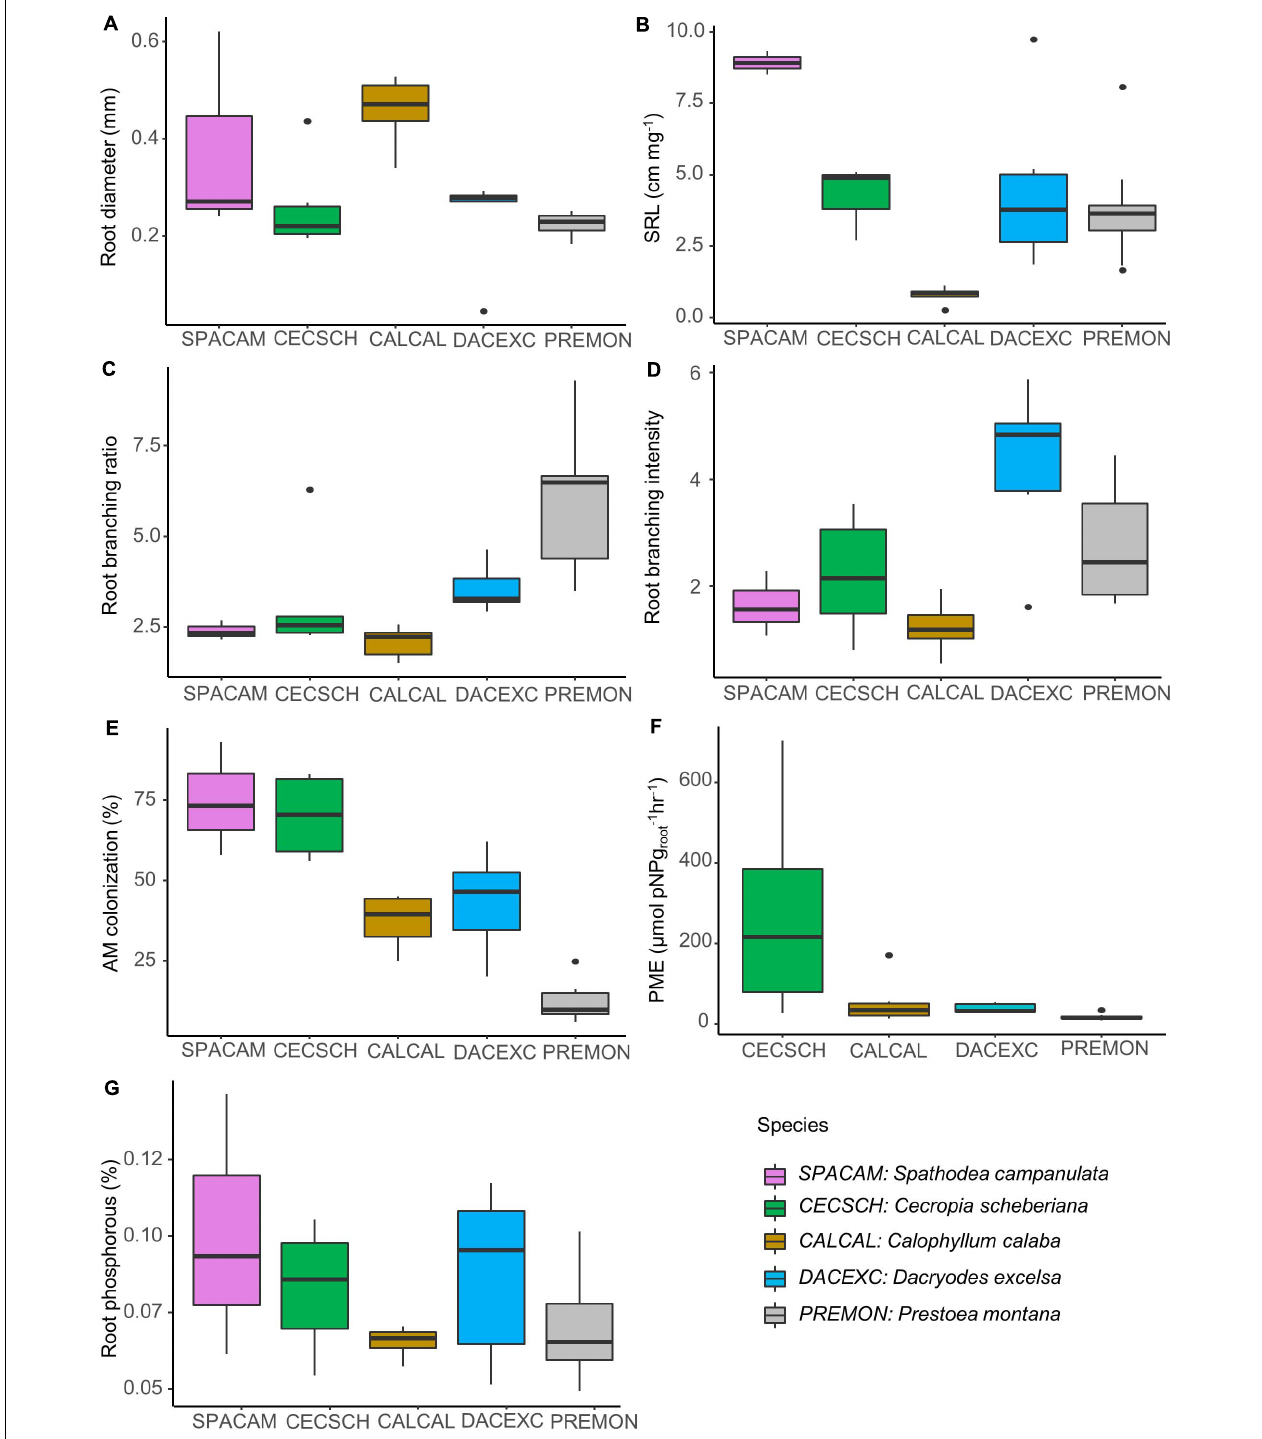
FIGURE 3 | Fine-root trait values for five common trees species at the Luquillo Experimental Forest in Puerto Rico. (A) Root diameter and (B) specific root length (SRL) were measured from 1 st root order. (C) Root branching ratio, (D) root branching intensity, (E) arbuscular mycorrhizal (AM) colonization, (F) root phosphatase activity (phosphomonoesterase; PME), and (G) root phosphorus concentration were measured from 1 st and 2 nd orders combined. Data are shown after the hurricanes that passed over the island in 2017. Due to sampling constraints, root PME activity was not measured for Spathodea campanulata .